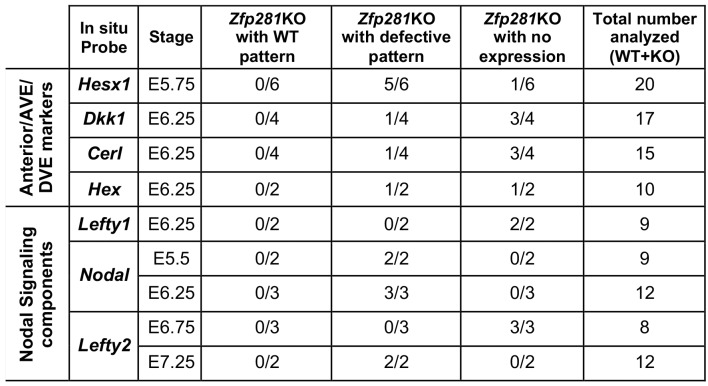
Table of markers and number of embryos analyzed by WISH.